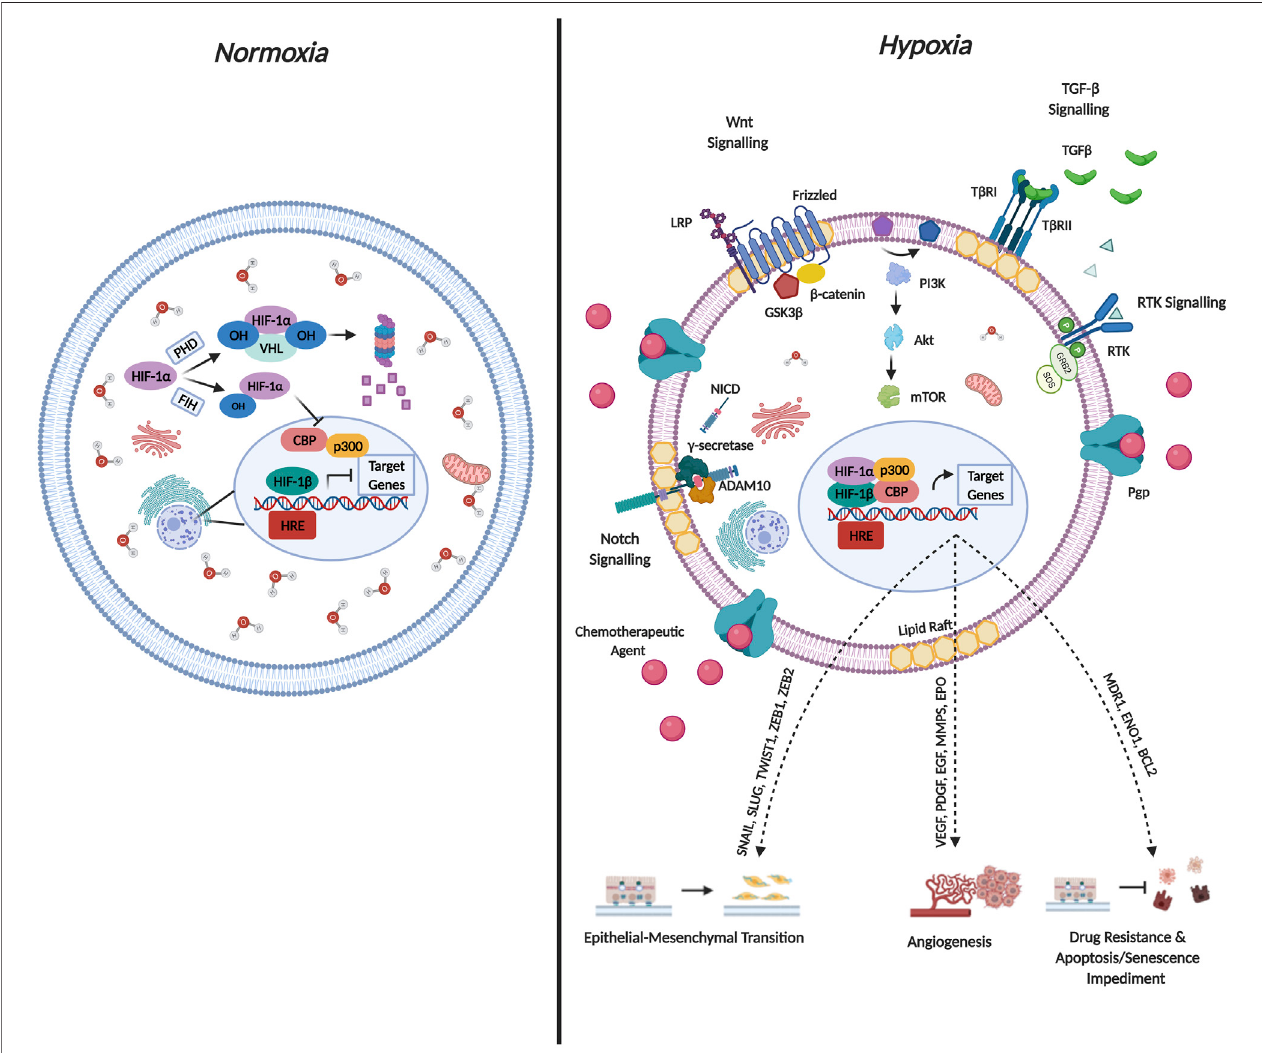
FIGURE 4 | Molecular Mechanisms Governing HIF-1 α Regulation and Cellular Function. Hypoxia-inducible factors (HIF ’ s) occur as heterodimers containing an oxygensensitivesubunit( α )andaconstitutivelyexpressed β subunit.Bothsubunitspossessabasichelix-loop-helix(bHLH)aswellasPER/ARNT/SIM(PAS)domainthat is required for DNA binding and dimerization. The oxygen dependent degradation domain (ODD) of HIF-1 α mediates oxygen dependent degradation. Under normoxic conditions, prolyl hydroxylase enzymes, hydroxylate HIF-1 α on conserved Pro residues within the ODD facilitating von-Hippel-Lindau mediated ubiquitination and subsequent proteasomal degradation. Additionally, Asn-hydroxylation mediated by factor-inhibiting HIF-1 α impedes interaction with the co-activators p300/CBP co- activator. Both mechanisms are documented to abrogate HIF transcriptional activation under normoxic conditions. Under conditions of hypoxia, the hydroxylases lose their activity, leading to HIF-1 α stabilization. HIF-1 α subsequently translocates to the nucleus and binds to HIF-1 β as well as the p300/CBP co-activator forming a complex.Theactivatedcomplexbindstomultiplehypoxia-responsiveelements(HREs)inthepromoterregionstoactivatetranscriptionoftargetgenes.Theconcomitant expression of target genes mediates cancer aggressiveness through EMT and angiogenesis induction as well as drug resistance and apoptosis impediment.